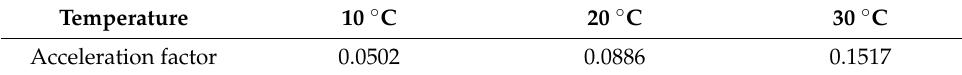
Figure 7. Regression and extrapolation results of the acceleration factors.